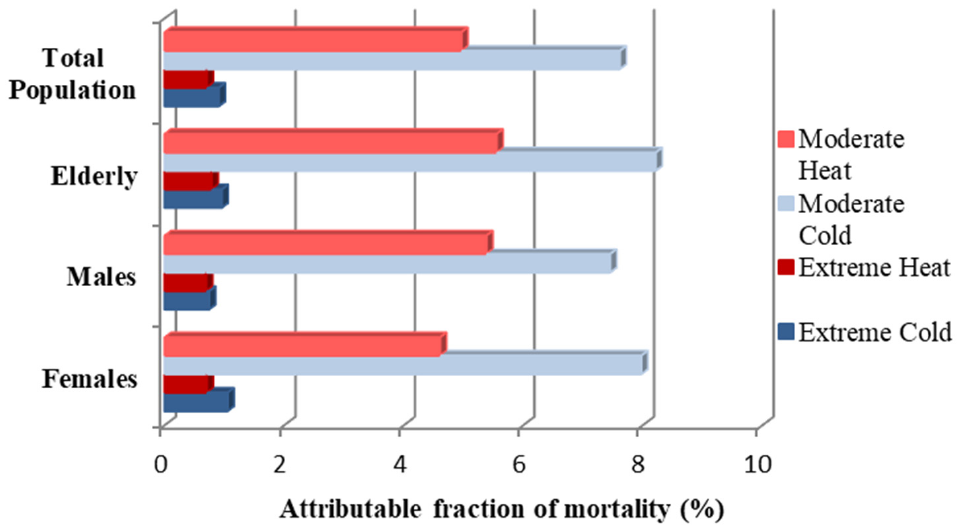
Figure 6. The fraction of mortality attributed to moderate and extreme temperatures for the total population and its subgroups in EMT.